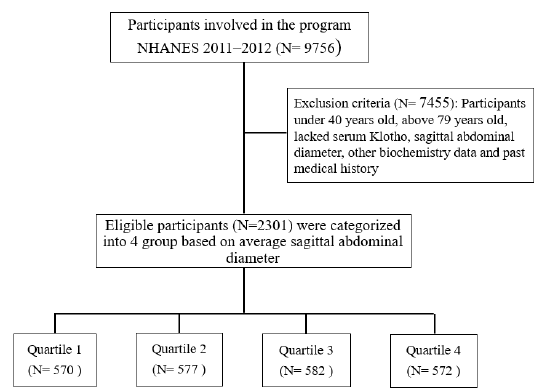
Figure 1. Study flowchart.